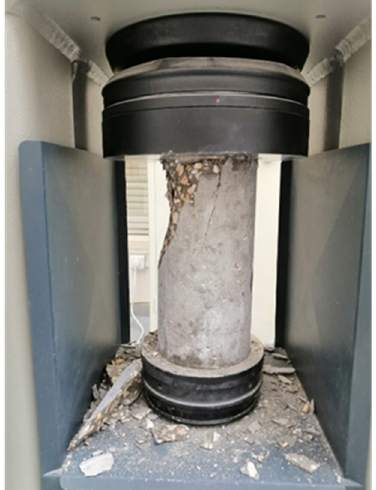
Figure 4. Concrete compression test.